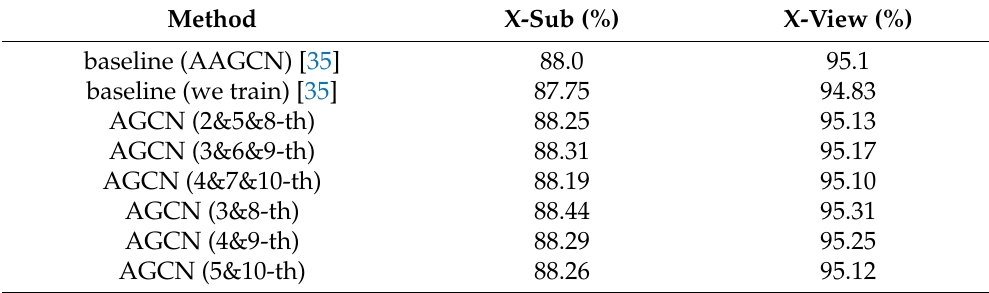
Table 3. Comparison of action recognition accuracy on the NTU-RGB+D dataset when the part attention module is added to different layers of the